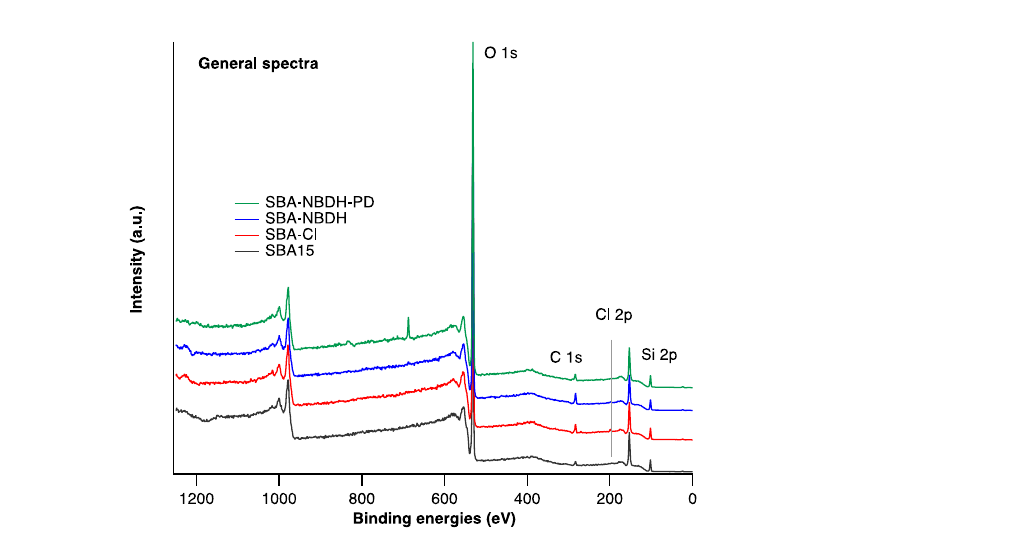
Figure 5. XPS general spectra of studied samples.